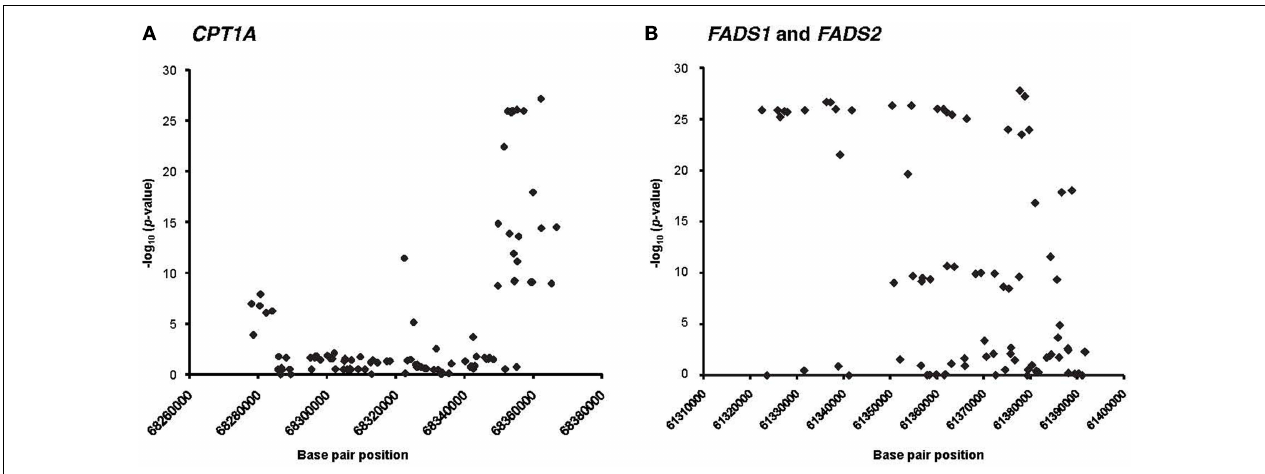
FIGURE 3 | Manhattan plots showing the association of SNPs on CPT1A and FADS1 and FADS2 with erythrocyte D5D. (A) CPT1A and (B) FADS1 and FADS2 .